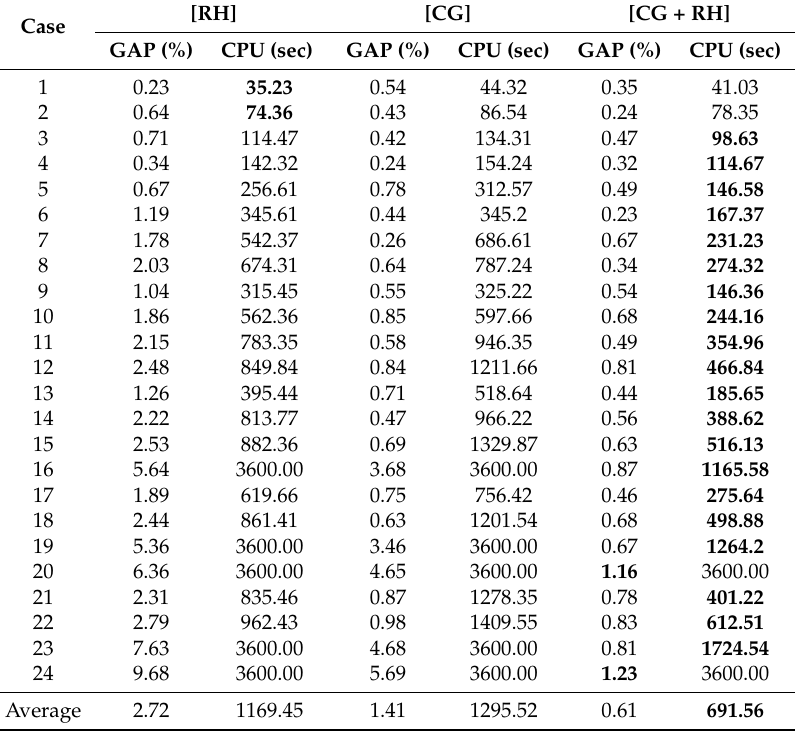
Table 5. Comparison between different solution